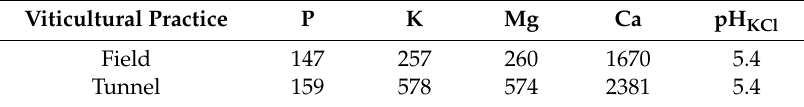
Table 1. Nutrient content (mg kg − 1 ) of the soil in two experimental